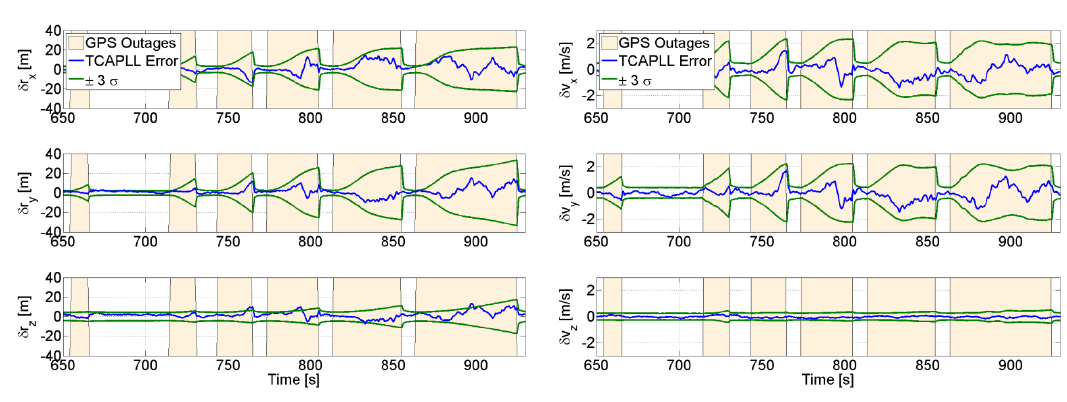
Figure 18. Position ( left ) and velocity ( right ) uncertainties during GPS partial